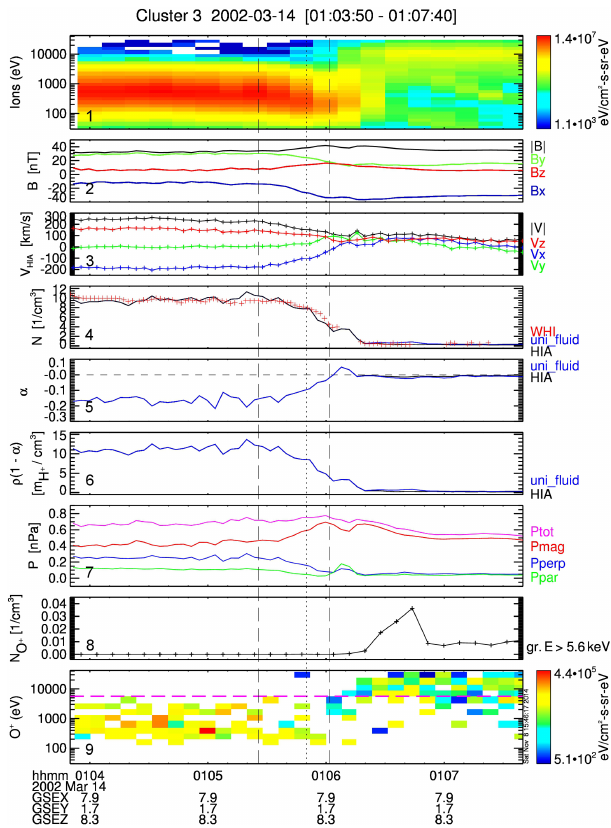
Figure 2. Magnetic field and plasma data for the inbound cross- ing from 14 March 2002 by Cluster 3. The top panel shows the HIA energy flux spectrogram; the next panels show the magnetic field magnitude and components, followed by the HIA bulk veloc- ity magnitude and components; panel 4 shows the HIA density (in black), superimposed on the WHISPER total electron density (red symbols), followed by the pressure anisotropy factor α and ρ( 1 − α) in panels 5 and 6; panel 7 shows the magnetic field pressure (red), perpendicular (blue) and parallel (green) ion pressure, and the sum of the magnetic and perpendicular ion pressures (magenta). The last two panels give the O + density and energy spectrogram, as deter- mined from the CODIF measurements. For the O + density, only the four highest energy channels, roughly above the 5.6keV thresh- old indicated by the horizontal magenta line in the last panel, have been taken into account. The magnetic field and plasma bulk veloc- ity components are in GSE coordinates, with x in blue, y in green, and z in red. In panels 4, 5, and 6, the quantities which include the uni-fluid correction are shown in blue. The black vertical dashed lines indicate the interval used for the HT/Walén analysis, while the vertical dotted line roughly indicates the center of the current layer.